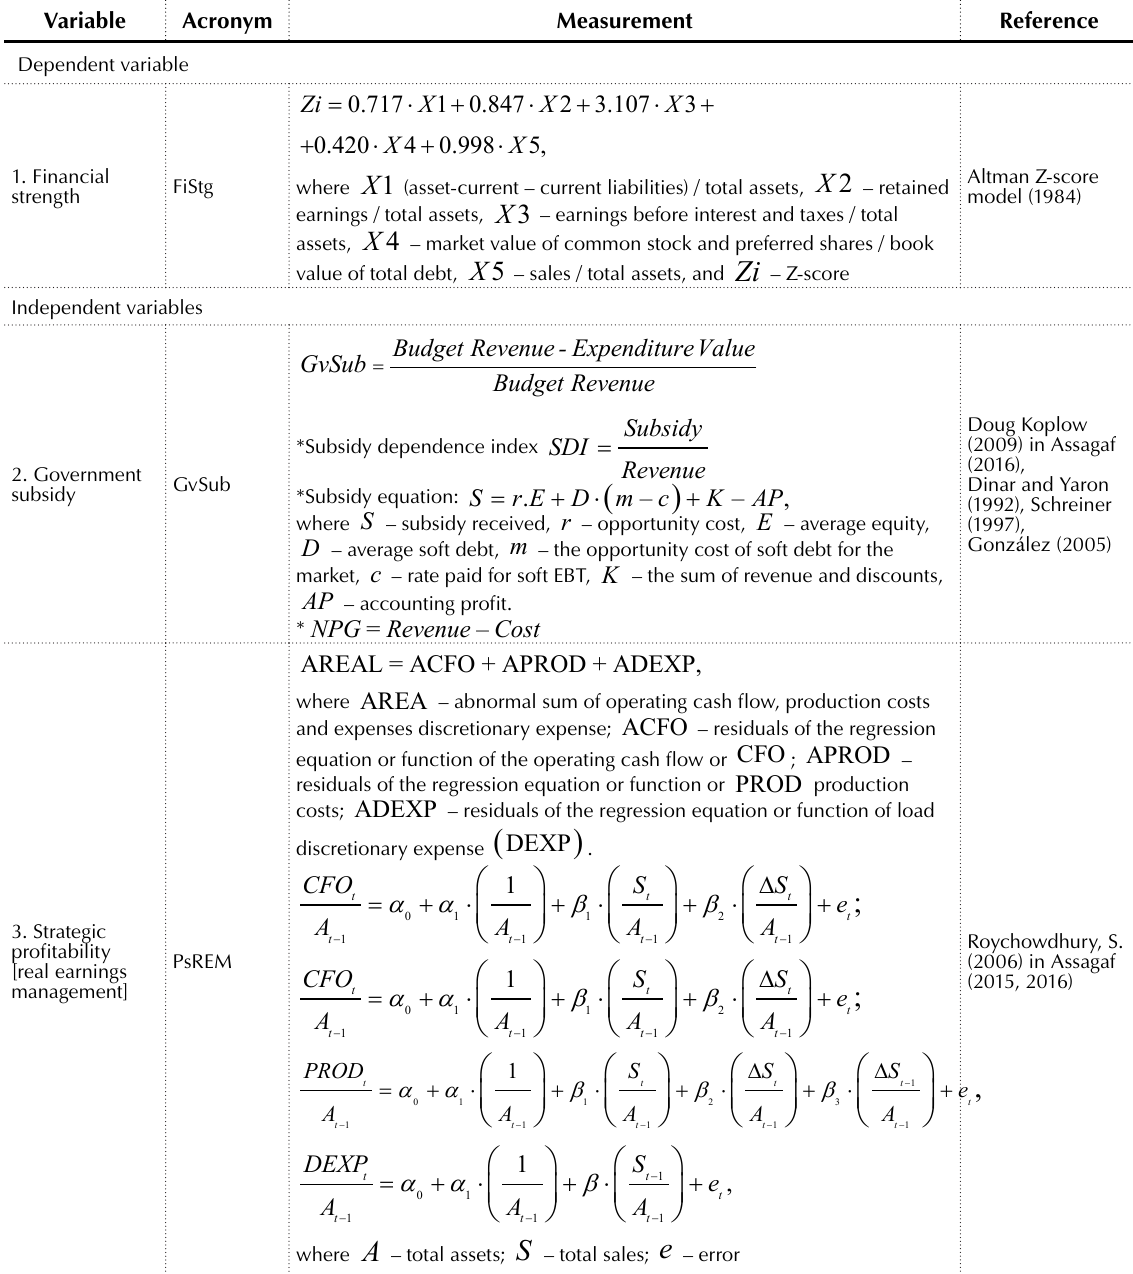
Table 1. Operationalization of